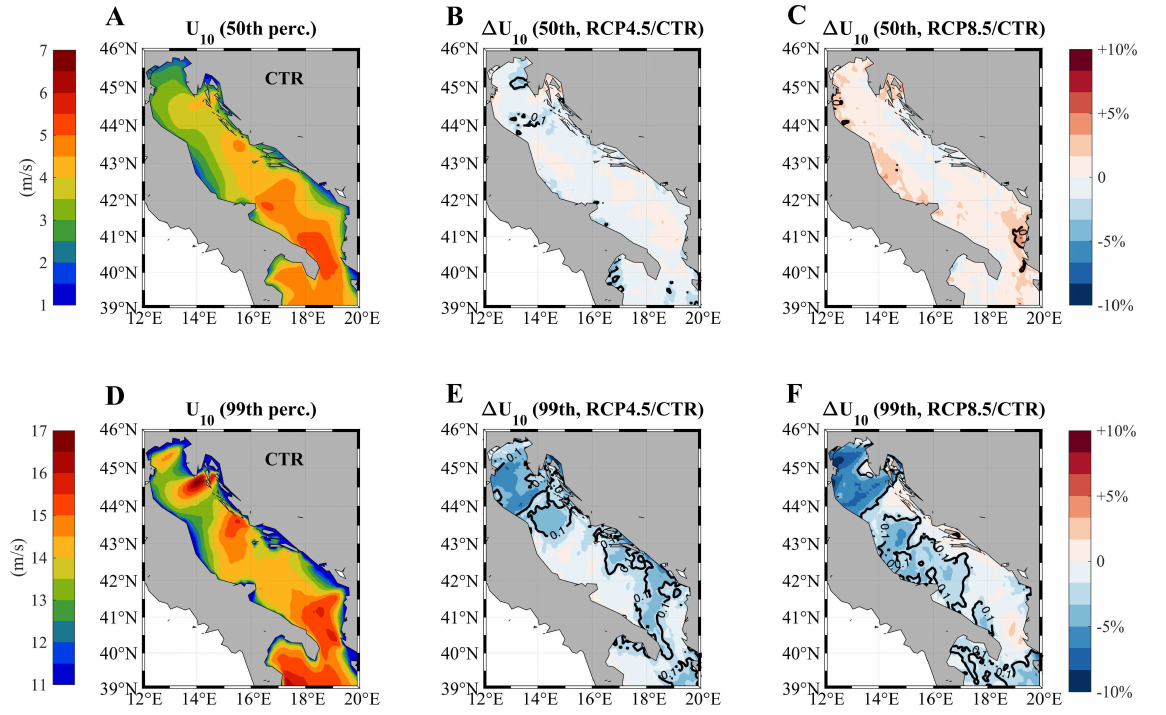
Figure 12. Climatology of the sea surface wind speed ( U 10 , in m/s) for the present day (1981–2010; ( A , D )) and projected relative changes for the near-future period 2021–2050 under RCP4.5 ( B , E ) and RCP8.5 ( C , F ) scenarios. Annual average of the 50th percentile ( A – C ) and 99th percentile ( D – F ) from CCLM-CMCC model fields over the Adriatic Sea and the North Ionian Sea. The black contours in ( B , C , E , F ) show the Mann–Whitney probability p -value of